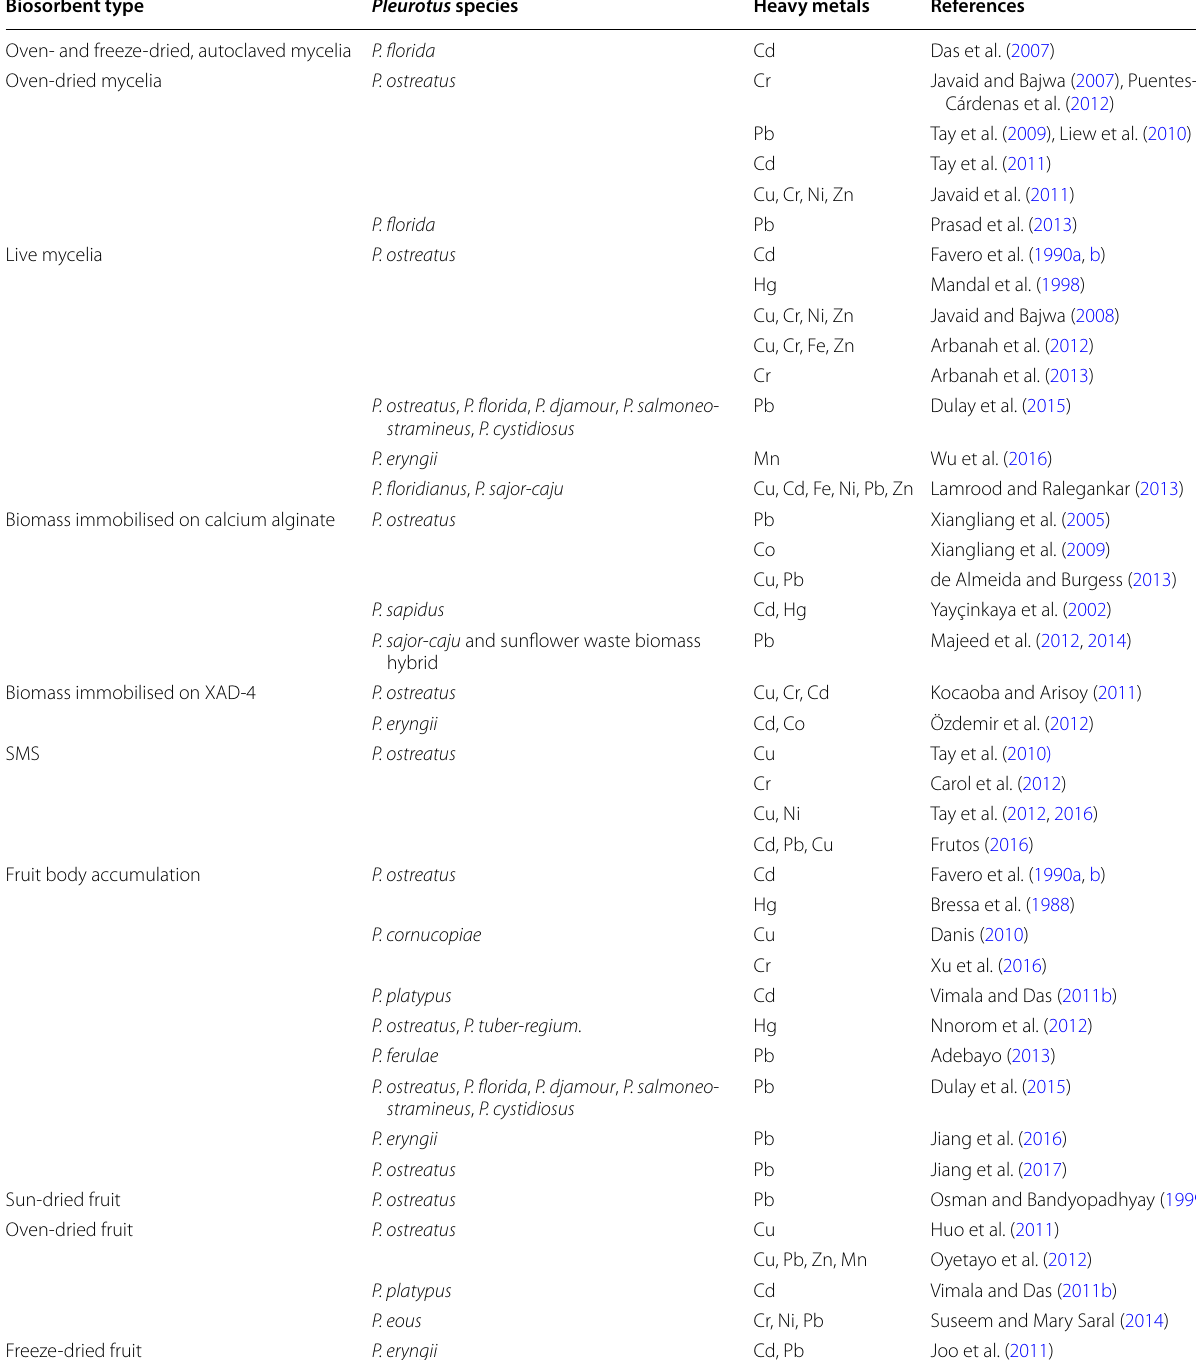
Table 1 Previous contributions of heavy metals biosorption using different forms of Pleurotus species Biosorbent